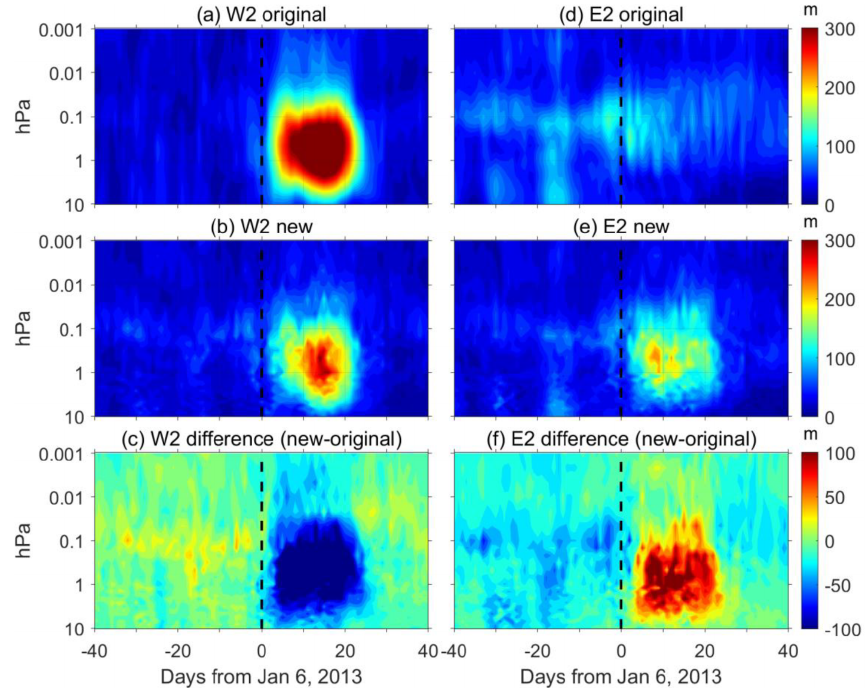
Figure 5. Same as Fig. 4 but for the W2 and E2 Q5DOs during the 2013 SSW.